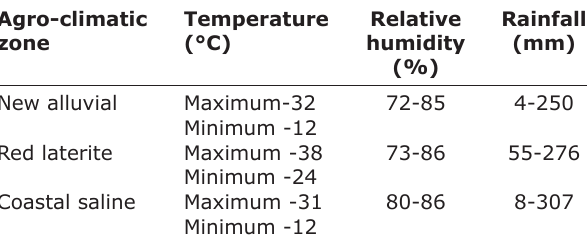
Table-5: Meteorological parameters of the study areas (agro-climatic zones) during collection period (July, 2010- December, 2013). Agro-climatic